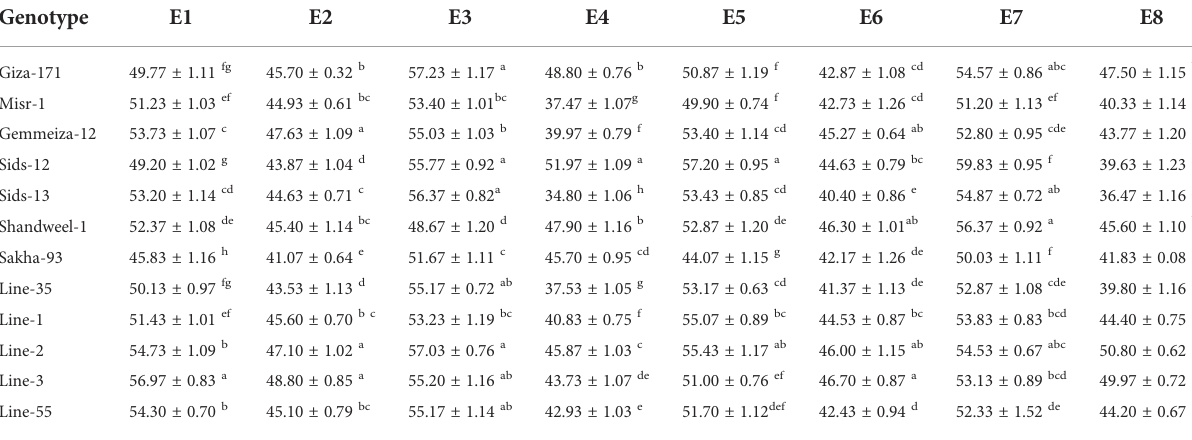
TABLE 6 Number of grains per spike for twelve bread wheat genotypes in two locations (Kafer El-Hamam and Sakha) during two growing seasons in 2015-2016 and 2016-2017 under timely and late sowing dates.